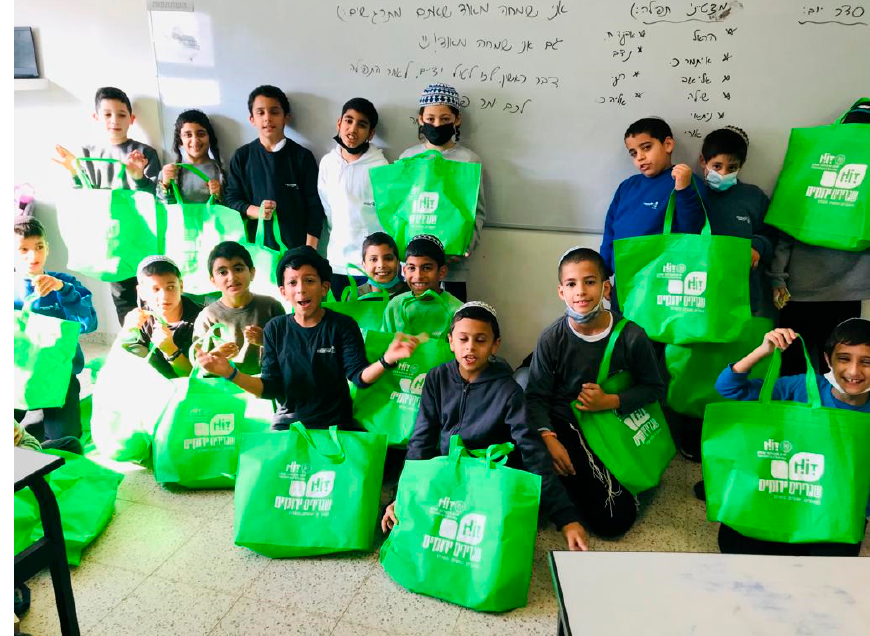
Figure 1. The pupils get the experimental kits.